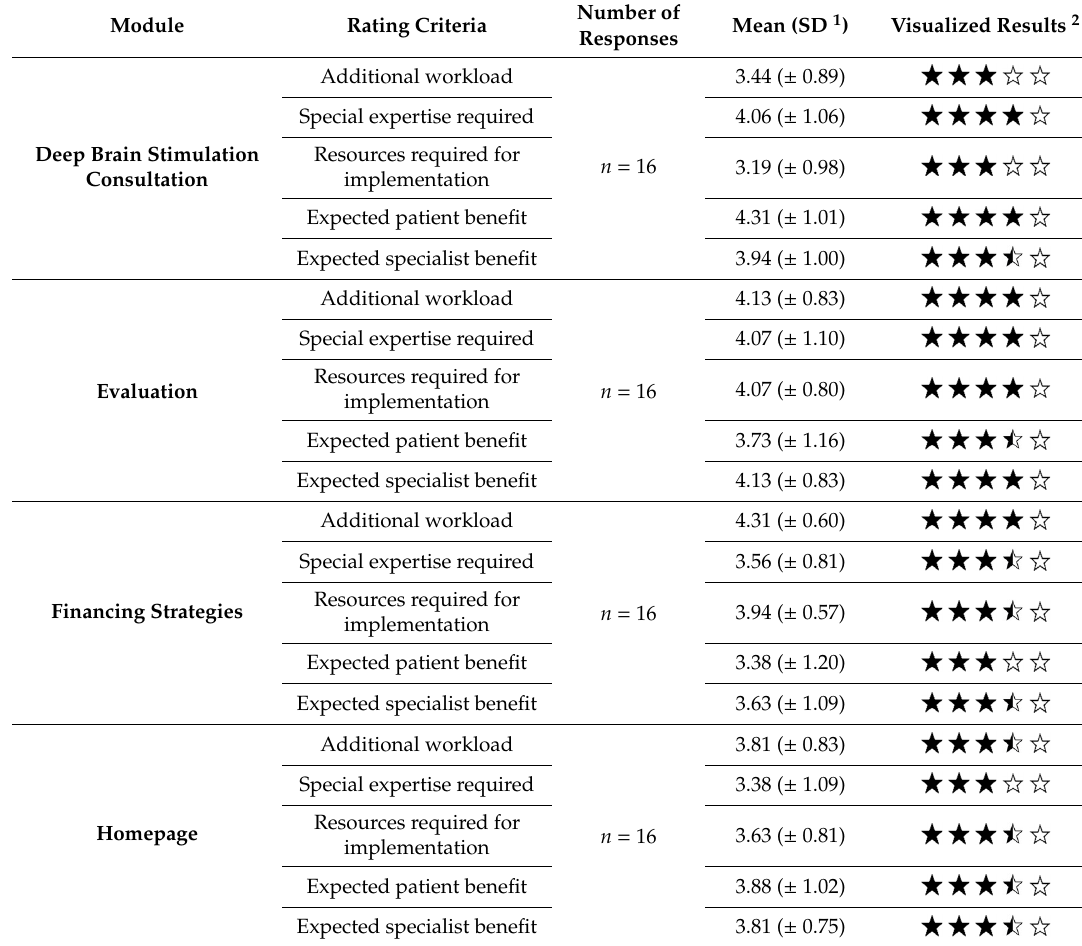
Figure 3. Box Plots for the Rating Categories and Rating Values (Modules: n = 25, Raters: n = 17) . Table 1. Expert Rating for German Parkinson Network Modules .